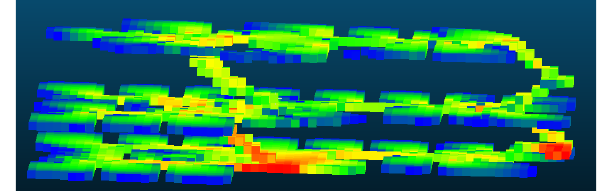
Figure 11. Current flowing through voxels during evacuation